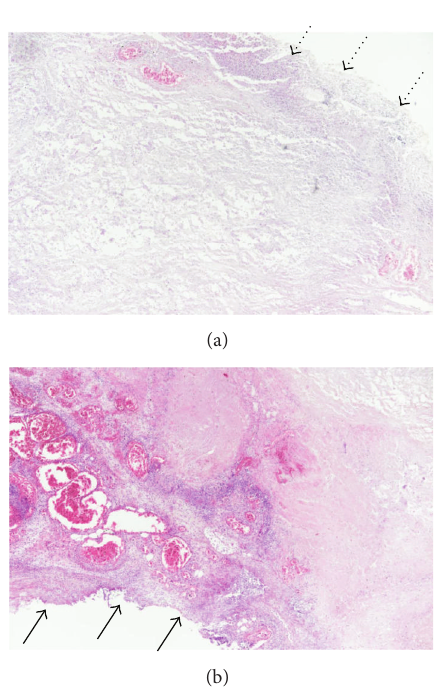
Figure 4: Histopathology ( × 100). Necrosis from mucous membrane (a) to serous membrane (b). Dotted arrow shows mucous mem- brane. Black arrow shows serous